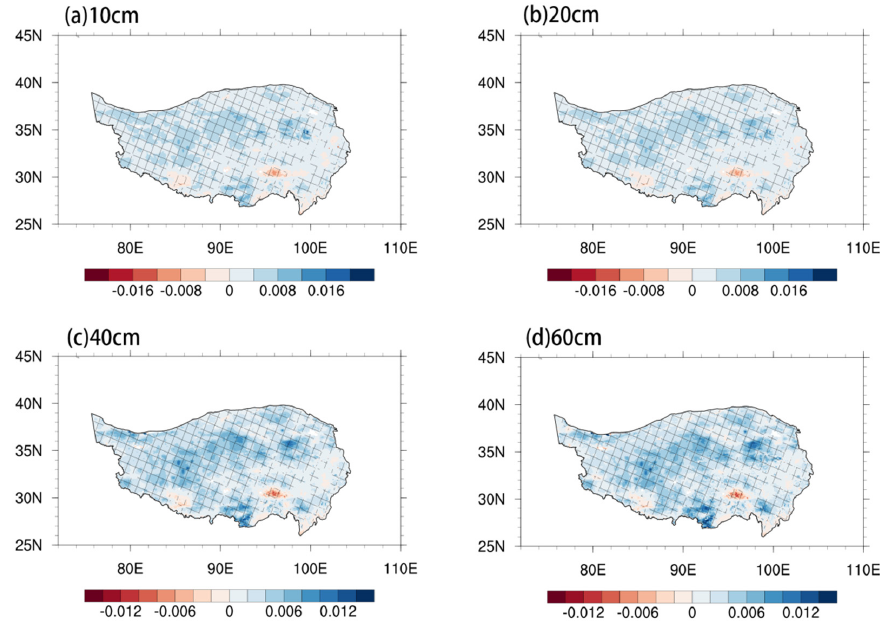
Figure 6. Same as Figure 5, but for soil moisture (unit: m 3 · m − 3 /decade). To better study the influence of air temperature on soil temperature, soil moisture, and freeze–thaw processes, Figure 7 shows comparisons of the annual average soil temperature between RW (from 1999 to 2016) and RC (from 1980 to 1998); the average soil temperature differences, at depths of 10, 20, 40, and 60 cm between RW and RC, were 0.568, 0.562, 0.555, and 0.546 ◦ C, respectively. The soil temperature differences across most of the TP were positive (and above 0.5 ◦ C) at all four depths, but the differences in the northwestern TP were negative. In addition, the maximum difference was found in the southwest, indicating that the soil temperature in this region is most sensitive to changes in air temperature. As the soil depth increased, the difference in soil temperature decreased slightly. The spatial distribution of the difference in soil temperature is consistent with the temperature